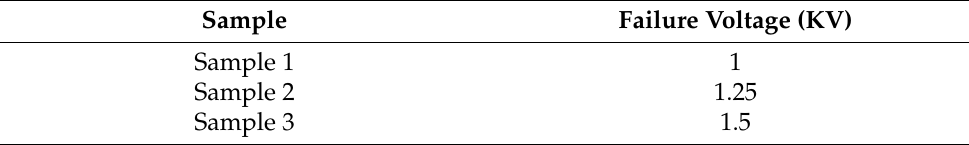
Table 1. HBM test results with raw test chip